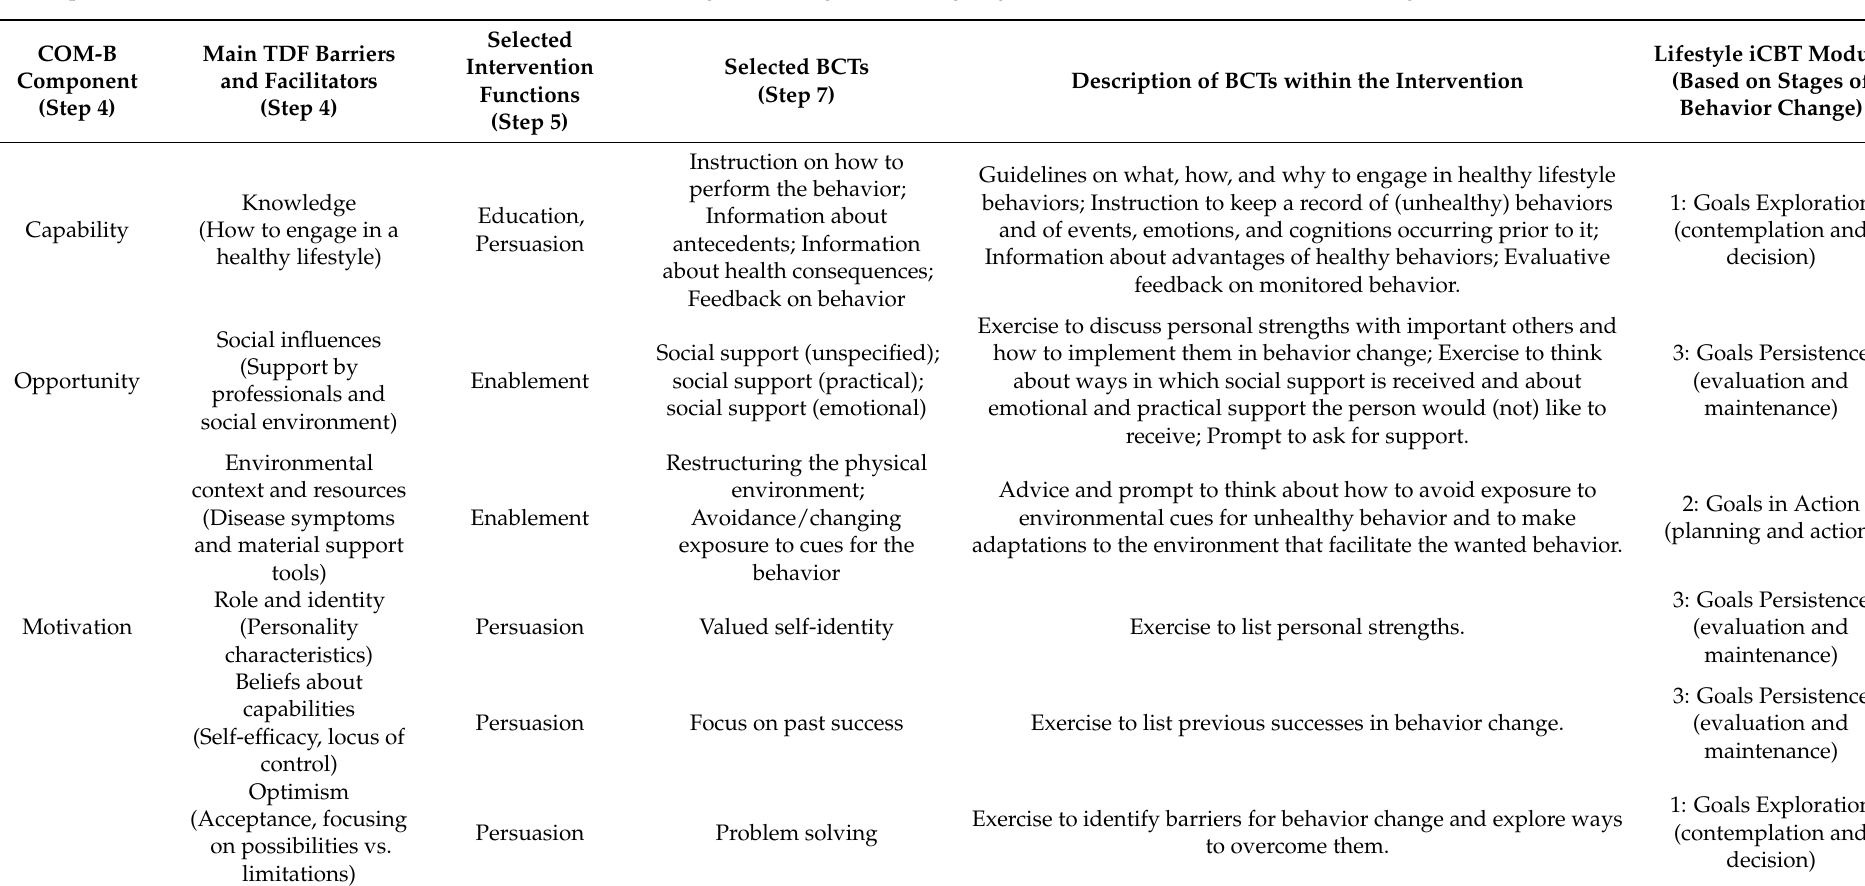
Table 2. Matrix of links between COM-B system, TDF domains, selected intervention functions, and selected BCTs in the lifestyle modules (BCW steps 4, 5, and 7). Matrix template adapted from S. Michie, L. Atkins, and R. West, The behaviour change wheel: a guide to designing interventions; UK: Silverback Publishing, 2014.